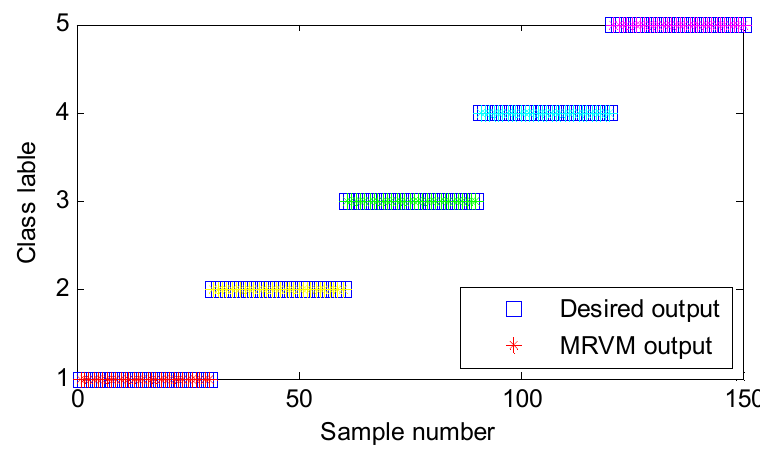
Figure 16. Identification result of the proposed method in the first trial.